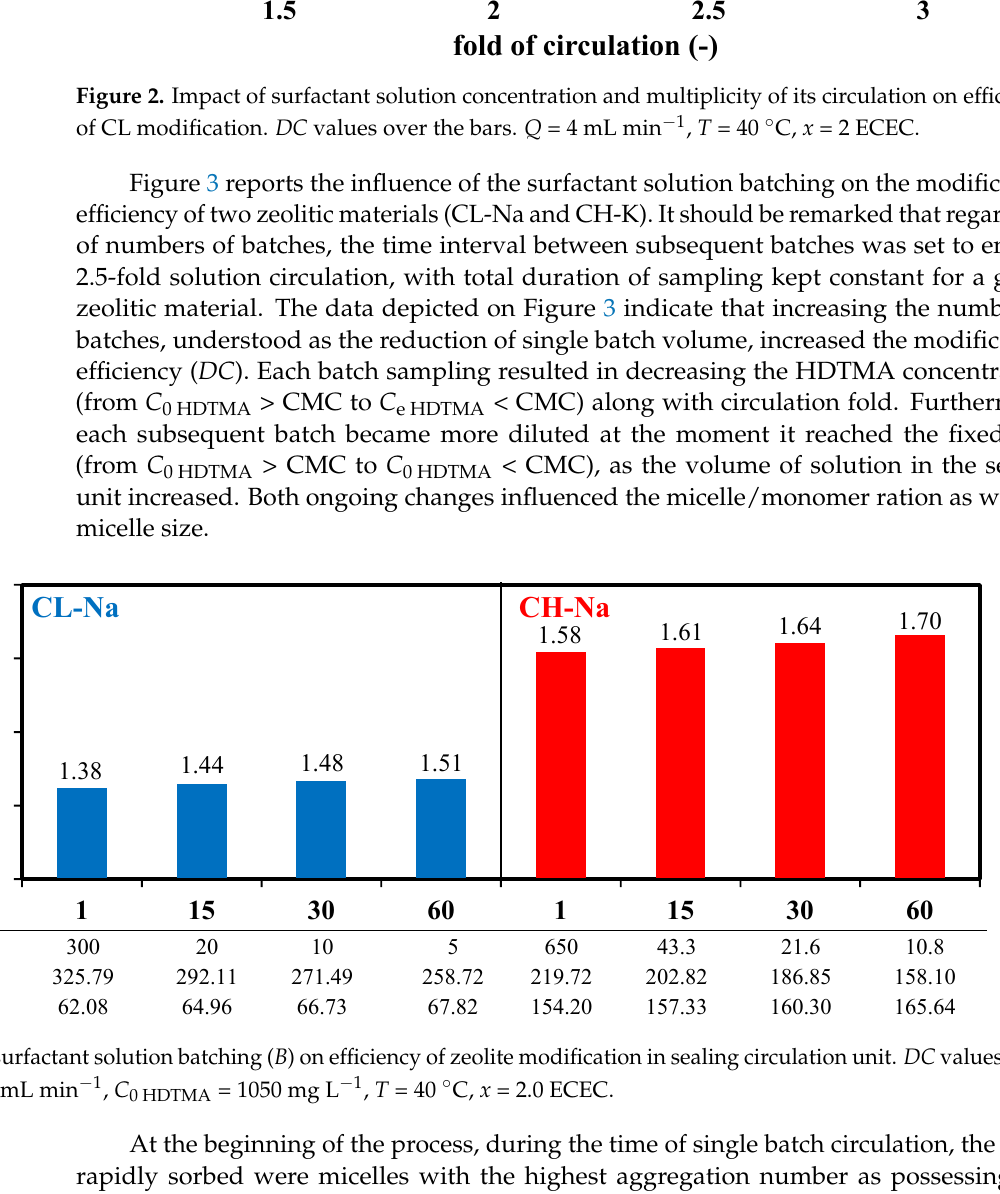
Figure 2. Impact of surfactant solution concentration and multiplicity of its circulation on efficiency of CL modification. DC values over the bars. Q = 4 mL min − 1 , T = 40 °C, x = 2 ECEC.